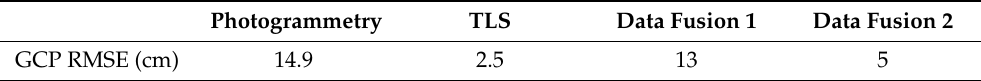
Table 6. RMSE errors of the check points for the data point